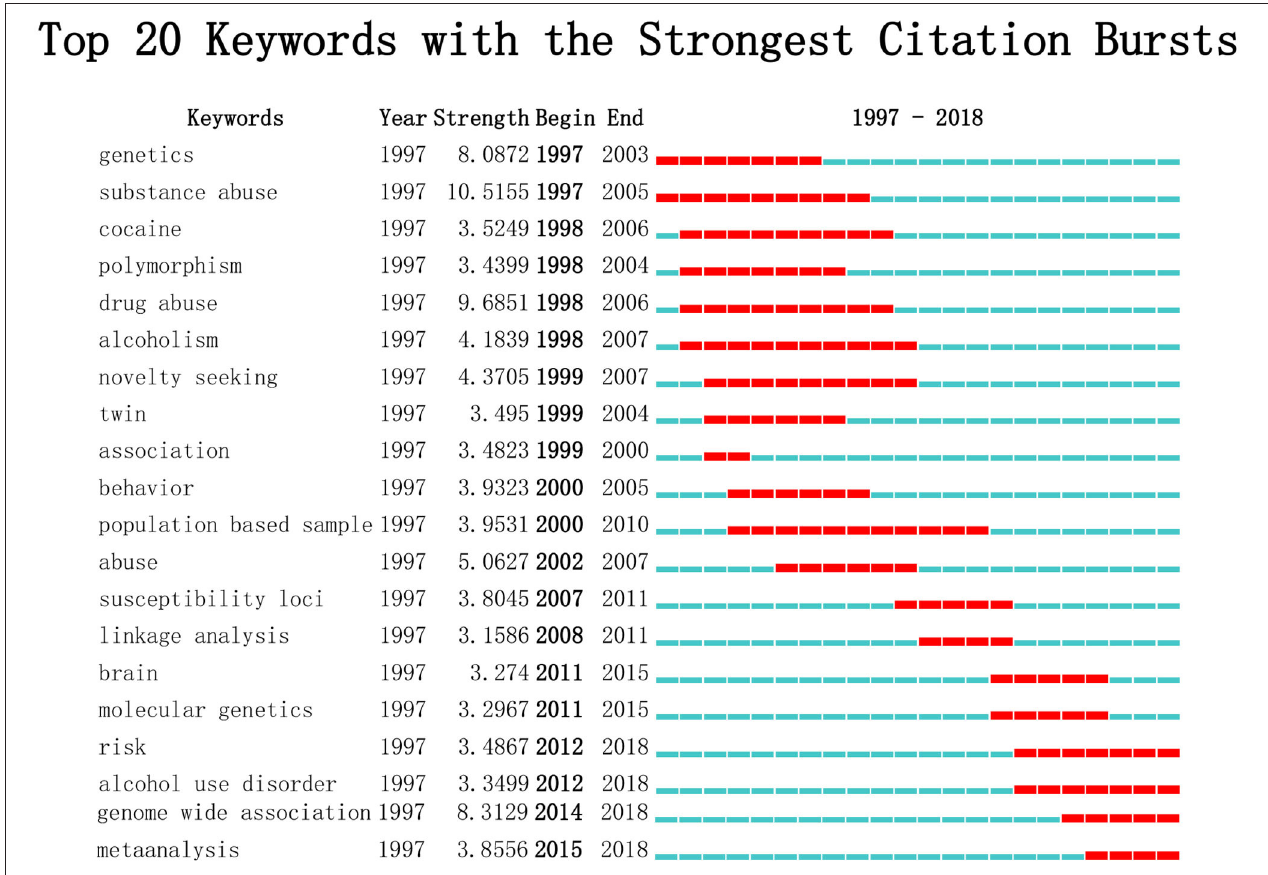
FIGURE 7 | Top 20 keywords with the strongest citation bursts. Each short line represents a year and the line in red stands for the burst detection years. Keywords with red lines extending to the latest year can indicate the research frontiers in a short period of time in the